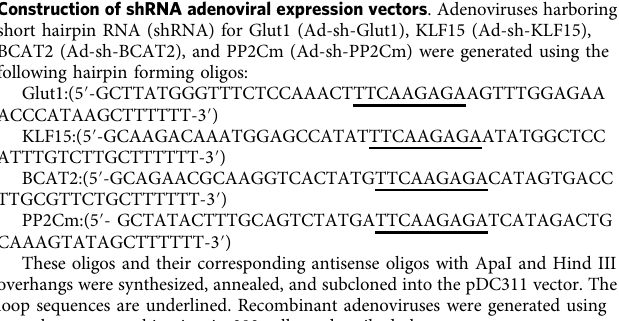
Annotation Chart analysis for general GO enrichment analysis and pathway enrichment analysis (Threshold: Count of 5 and EASE score of 0.05) using the KEGG pathway database 26 . KEGG pathway tool was utilized through DAVID online tools to visually map down-regulated genes involved in BCAAs degradation pathway in GLUT1-TG heart.